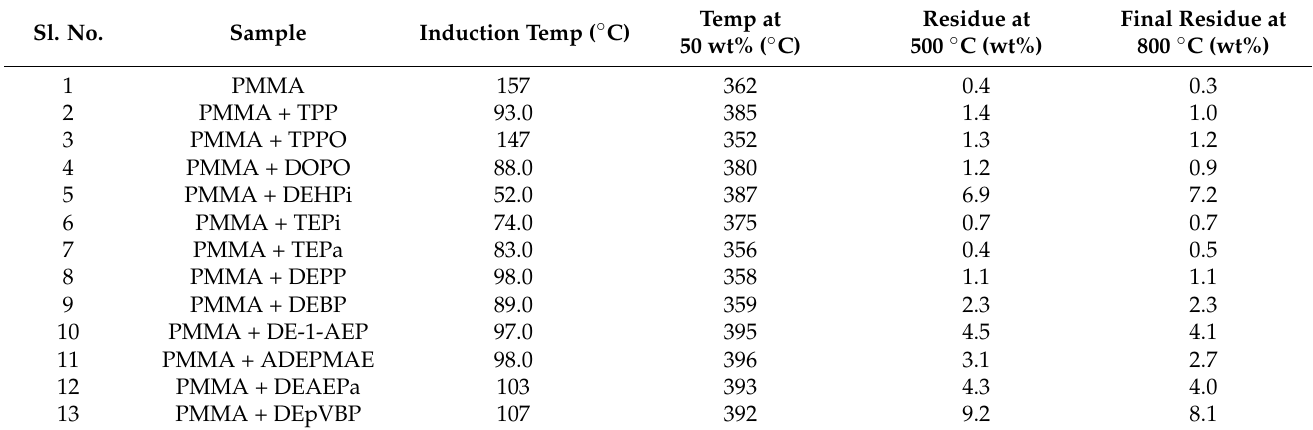
Table 3. Some relevant parameters from the TGA analyses of PMMA-based